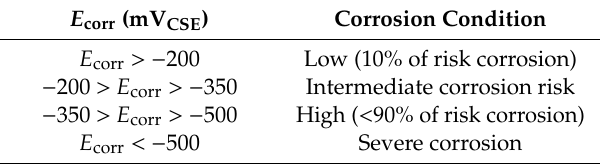
Table 7. The measured half-cell corrosion potential ( E corr ) versus a Cu/CuSO 4 in reinforcement concrete [86].